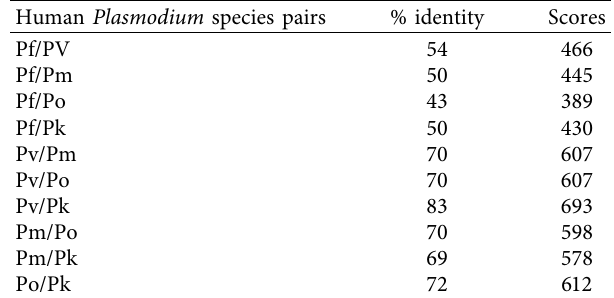
Table 6: Pairwise comparison of protein sequences of Domain I of AMA1 across human Plasmodium species using the pairwise se- quence alignment EMBOSS Needle